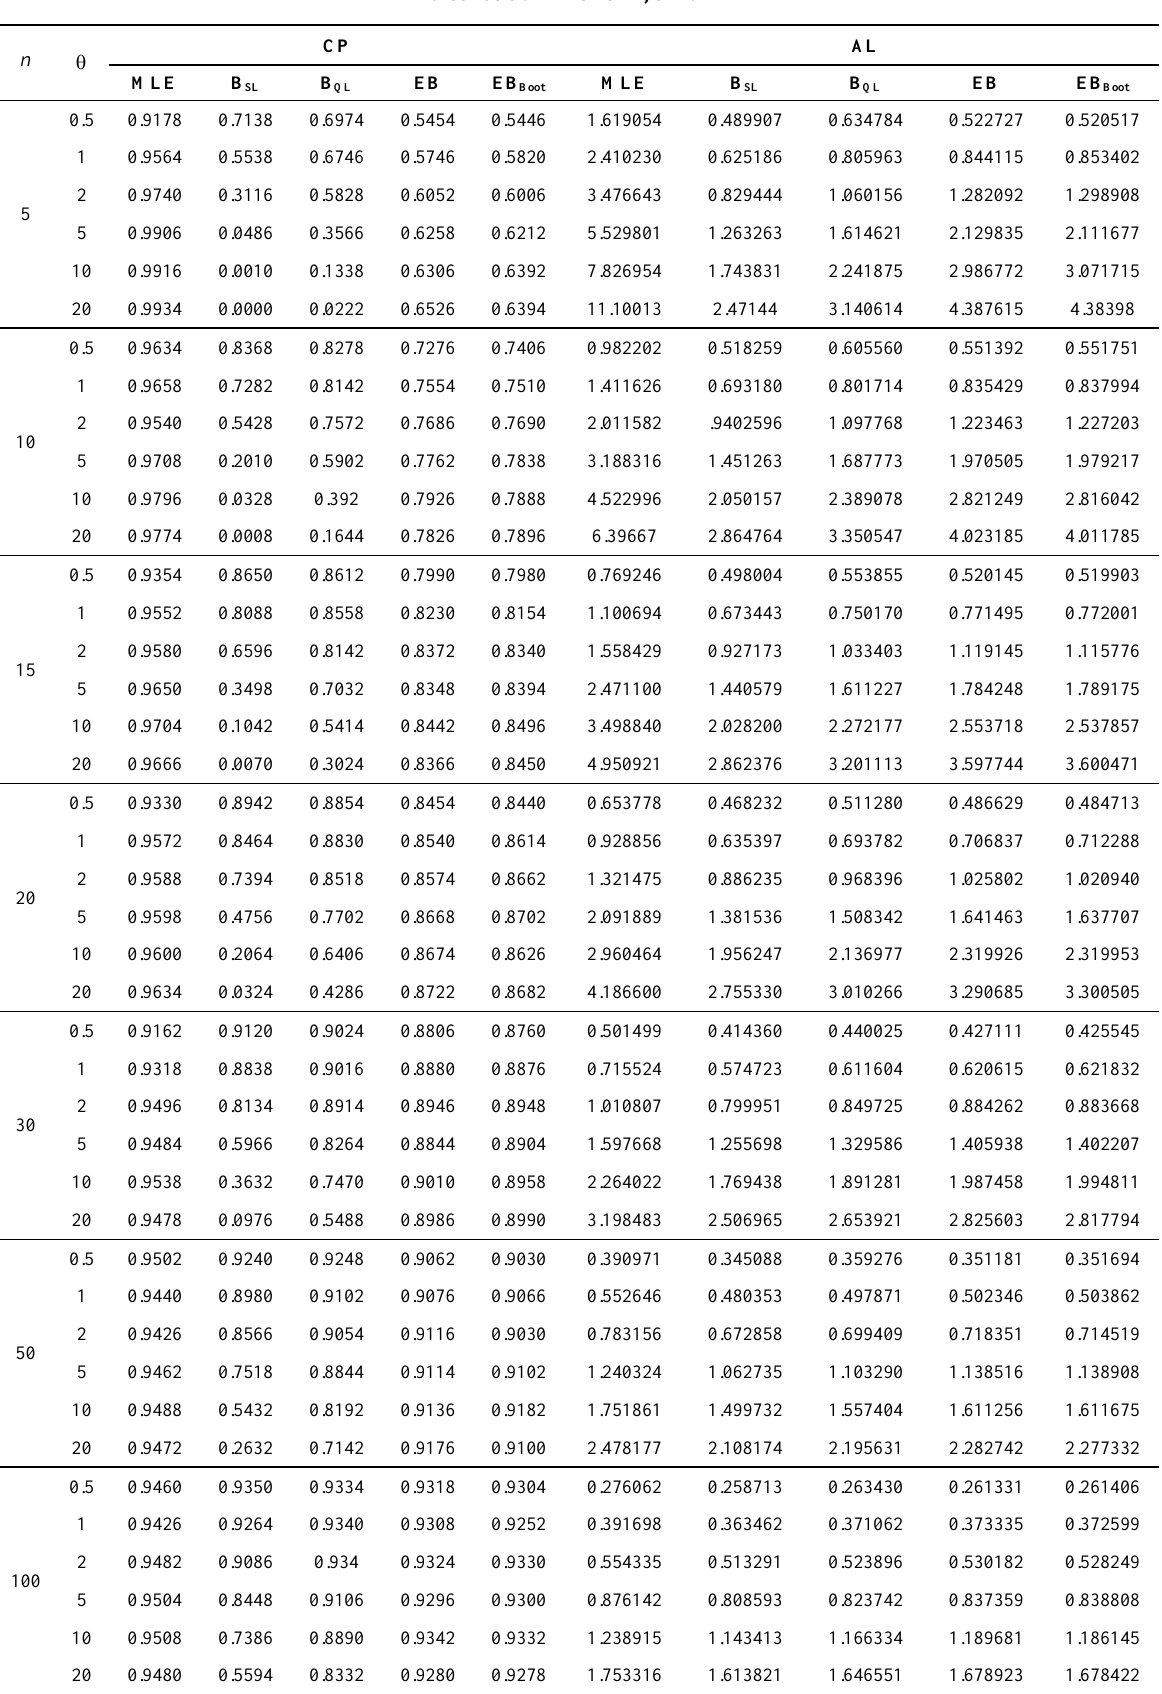
Table 6. Coverage probability (CP) and average length (AL) of 95% of confidence interval for the mean of Poisson distribution when a =2, b